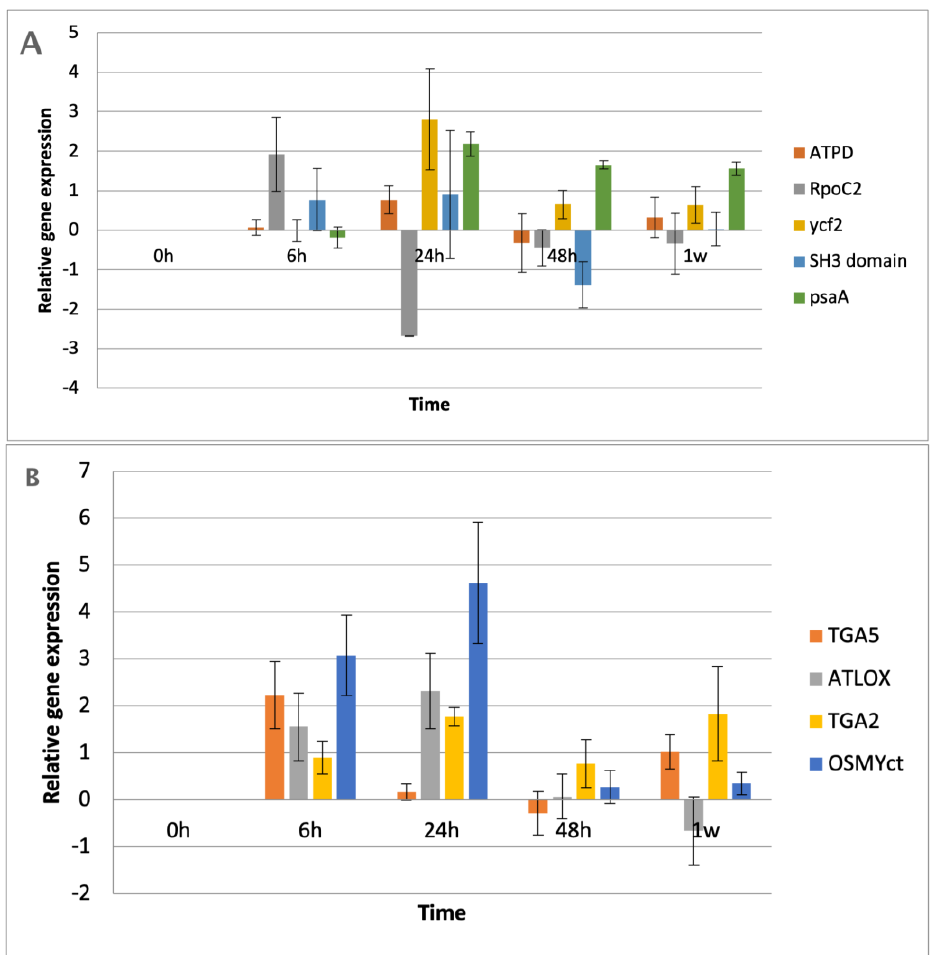
Figure 5. RT-qPCR Analysis of Differentially Expressed Genes after Biostimulant Application. ( A ) Selected genes related to photosynthesis and plant growth obtained by SSH library; ( B ) Genes related to SA and JA pathway activation.